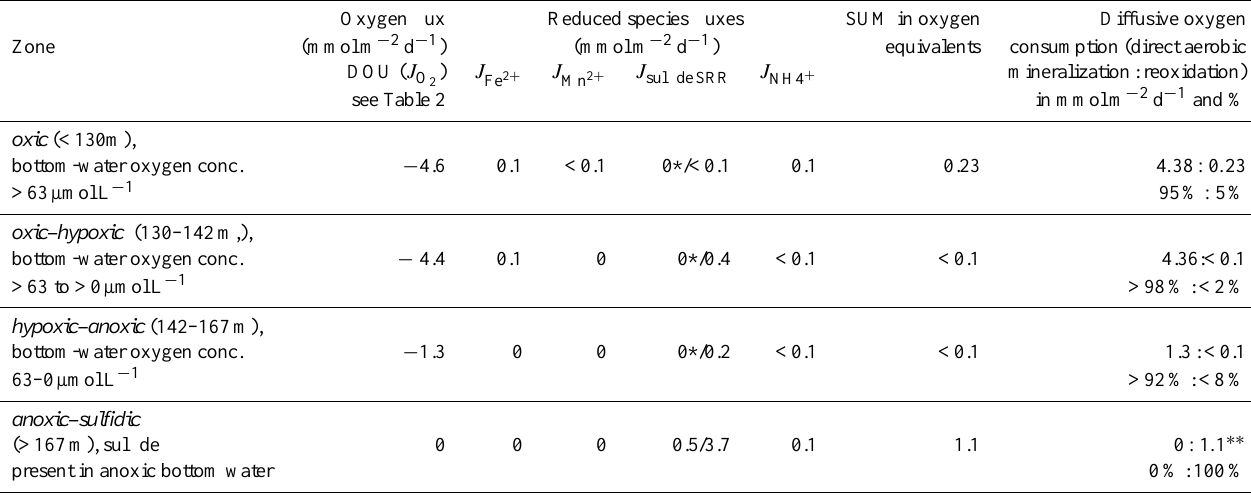
Table 3. Diffusive oxygen uptake compared to fluxes of reduced species, calculated from the modeled profiles (Fig. 7) or measured directly (SRR represents sulfate reduction rates). The sum of oxygen equivalents is calculated from the stoichiometry of the oxidation processes (respective formulas are displayed at the lower end of the table), and oxygen available for direct aerobic respiration is calculated by subtracting the potential oxygen demand from the available oxygen